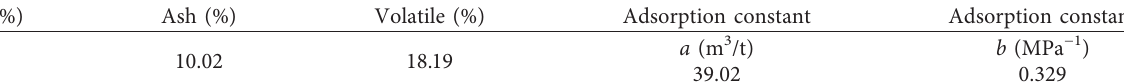
Table 2: Basic physical parameters of